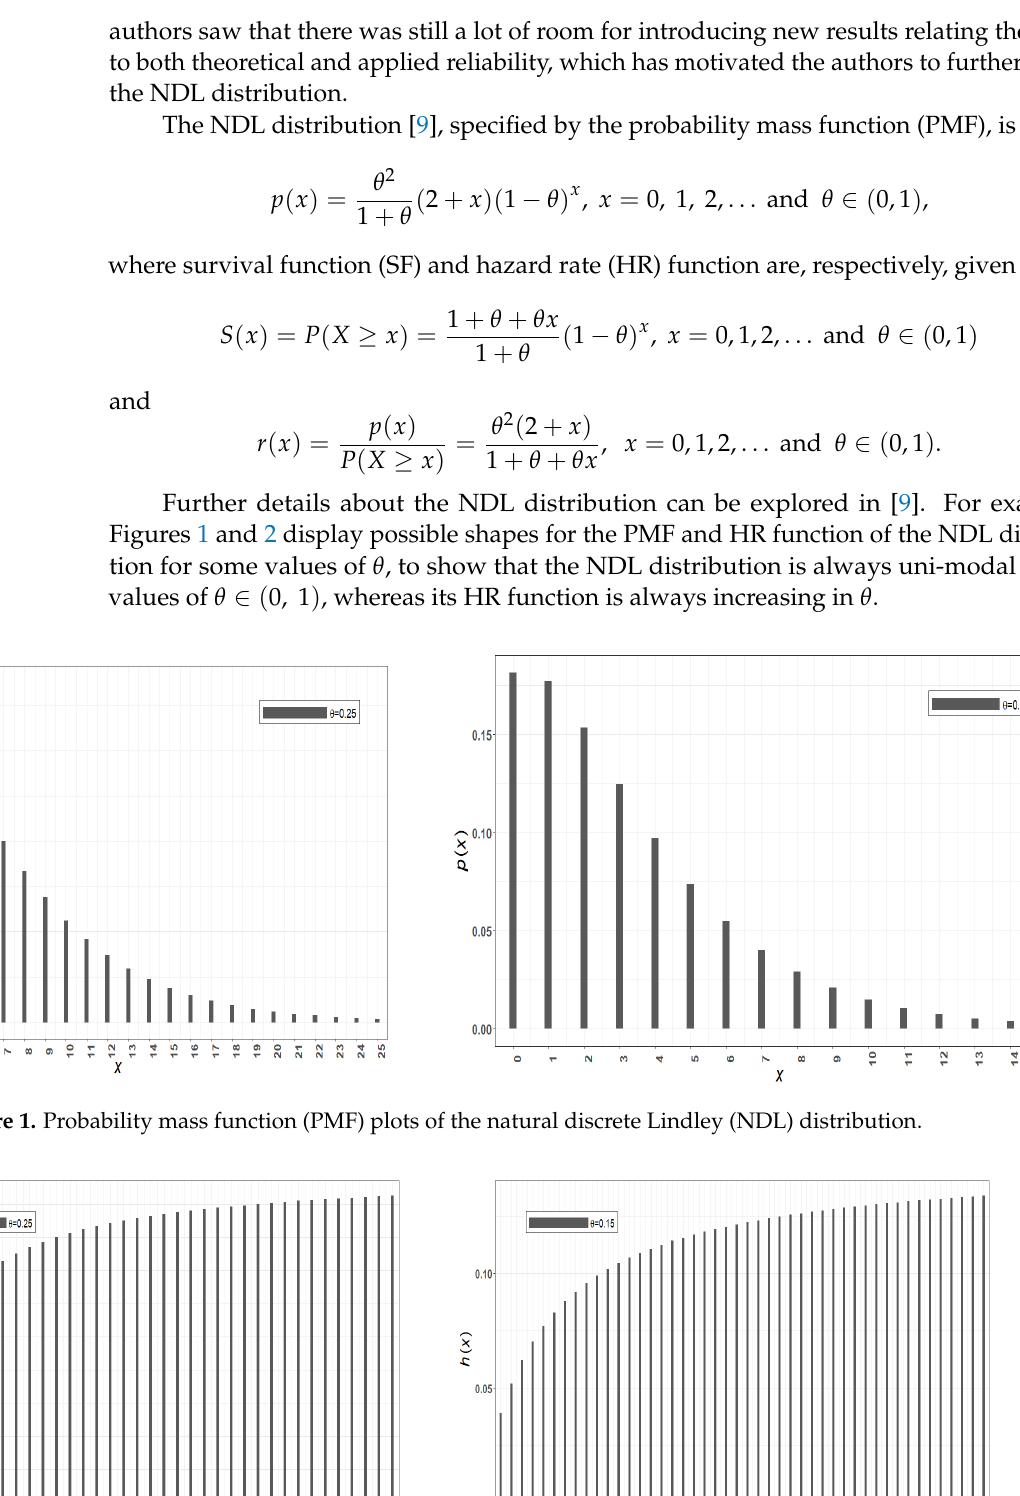
Figure 2. Plots of the hazard rate (HR) function of the NDL distribution.